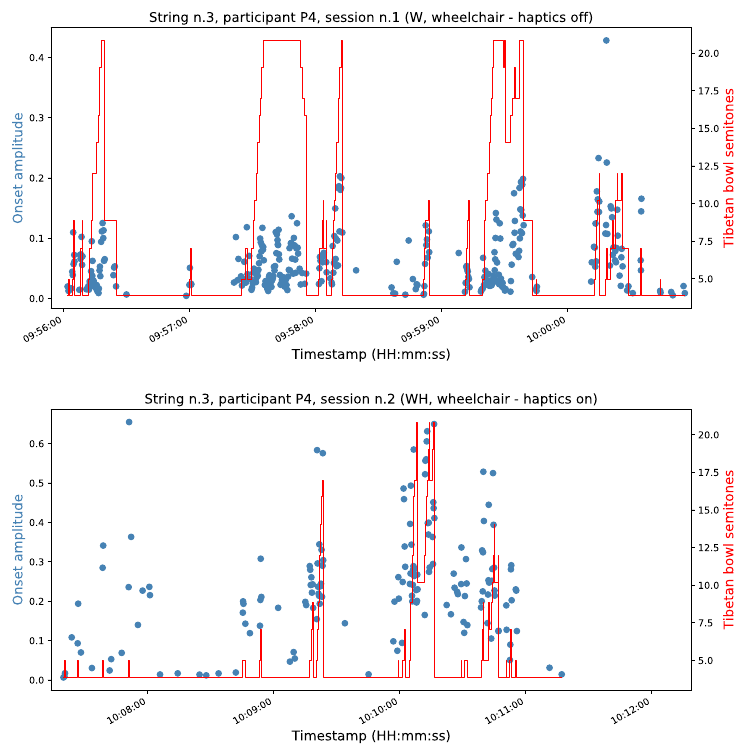
Figure 5. Plots of the detected onsets (in blue) for P4 in the first condition, W, ( top figure) and second condition, WH, ( bottom figure). The red lines represent the Tibetan singing bowl’s pitches, triggered through P4’s interaction with the string. A re-synthesis of these plots is available as Supplementary